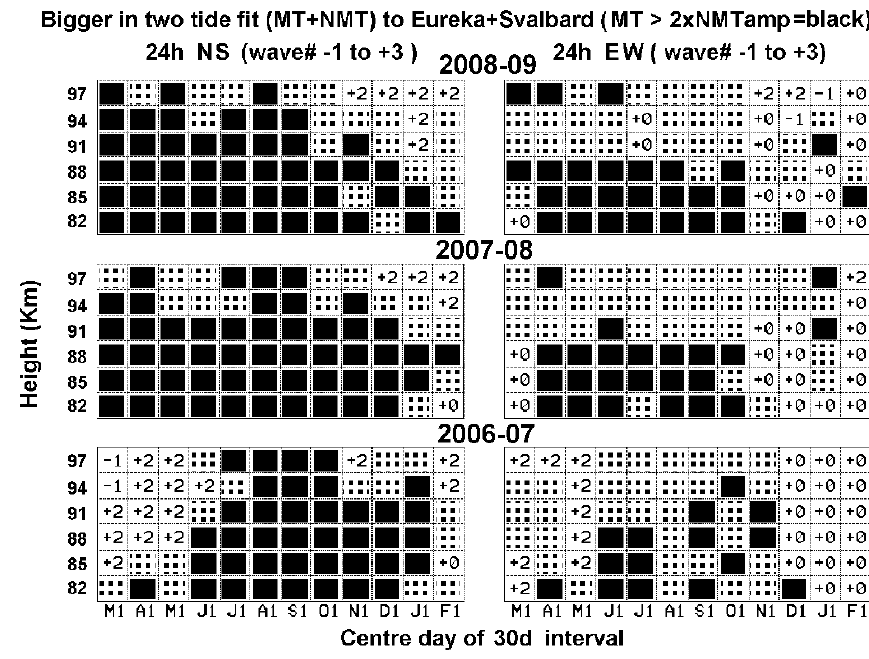
Fig. 3. Two-tide fits, using the wave number of the diurnal MT ( s = 1) plus one of a range of NMT, were used to find the relative sizes: a black square is chosen if MT is greater than twice any NMT value; a grey square is chosen when one or more NMT values are smaller then MT, but greater than 0.5 of MT; the wave-number “ s ” is chosen that has the largest NMT [relative to the corresponding MT amplitude] of all of the fits. Wave-numbers ( s =− 1 to + 3) are appropriate to non-linear interaction of the diurnal MT with the SPW S = 1 or